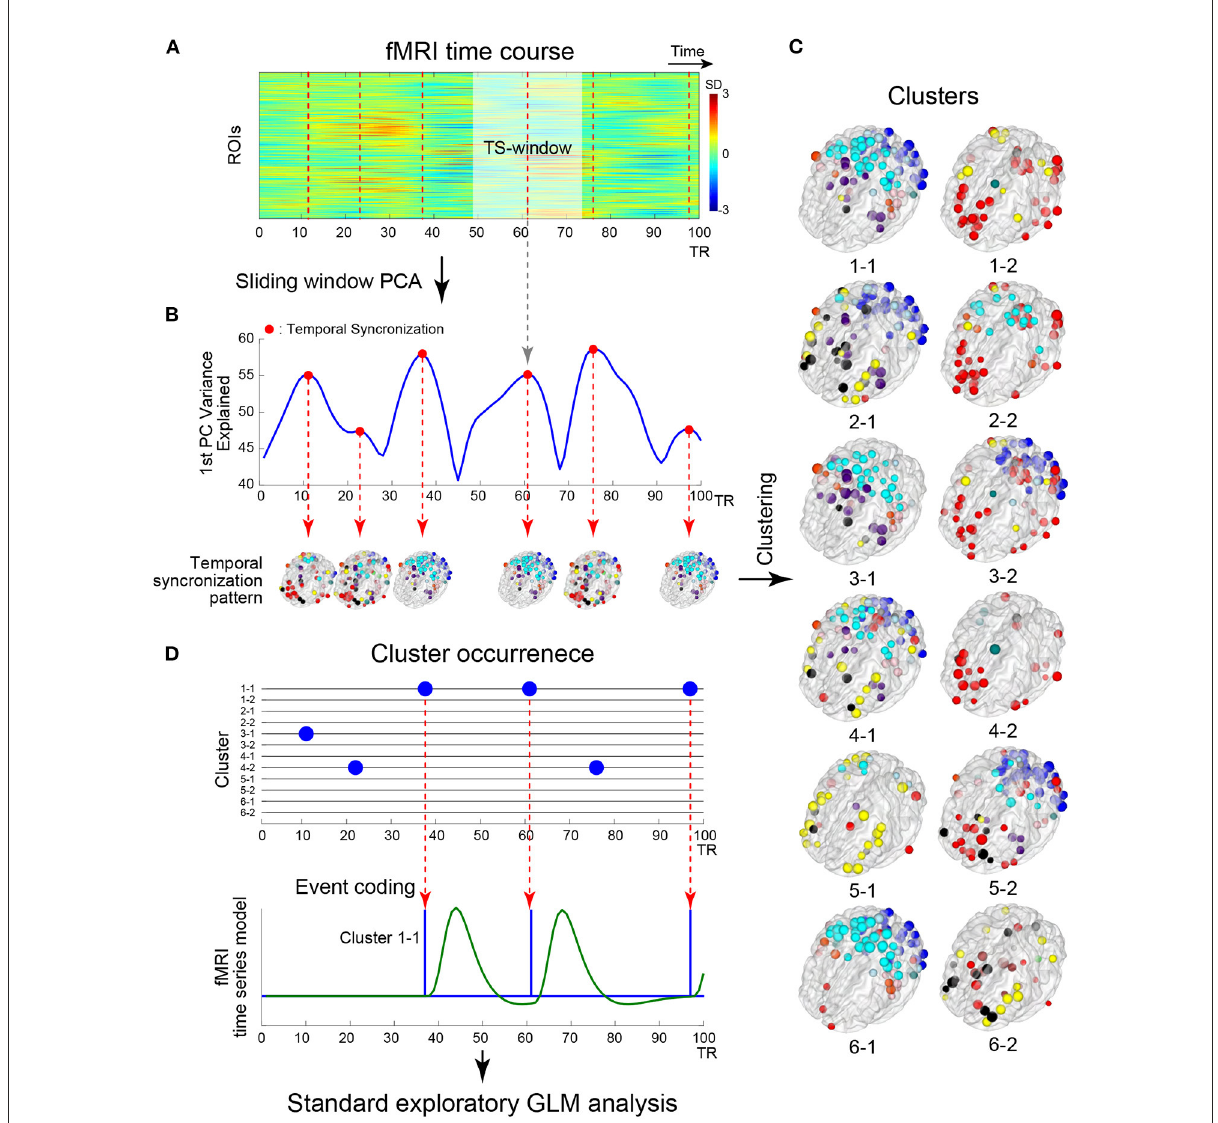
FIGURE1 Schematic illustration of the analysis framework. (A) Example timecourses of fMRI signals extracted from regions of interest (ROIs). The vertical and horizontal axes indicate ROIs and time, respectively. The color indicates the magnitude of standardized fMRI signals. The brighter rectangle area indicates a window where ROIs timecourses showed temporal sectorization [TS; see (B) ], and broken vertical red lines indicate TS time points. (B) Example timecourse of the variance explained by the first principal component (1 st PC, blue line). Red dots indicate local maxima of the variance, when fMRI signal temporally synchronized. ROIs showing strong synchronization were mapped onto the 3D surface of the brain. Colors of the ROIs indicate resting networks identified in prior work (Power et al., 2011). (C) Temporal synchronization patterns were labeled as clusters based on a transition matrix across the cluster in Supplementary Figure S3A. ROI-based pattern for each 12 cluster centroids comprising 6 pairs of clusters mapped onto the 3D surface of the standard brain. (D) Timecourses of cluster occurrence (top). The vertical and horizontal axes indicate clusters and time, respectively. The occurrences of clusters are indicated by blue dots. The occurrences of the clusters were coded as events in fMRI time series modeling (bottom). Blue and green solid lines indicate event onsets and BOLD model of the cluster occurrence. Whole-brain exploratory standard event-related GLM analysis was performed using resting-state data.